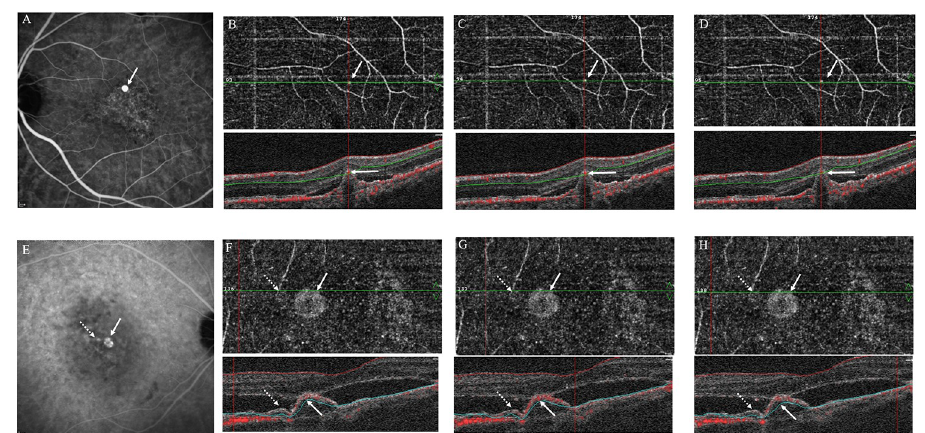
Fig 1. ICGA and OCTA of high-flow polyp and low-flow polyp. (A) ICGA revealed one polyp (arrow). (B~D) The polyp (arrow) was identified by en face flow OCTA, and flow signal (arrow) was identified by en face flow OCTA, and flow signal was detectable in all 3 consecutive horizontal scans at the center of the polyp. The polyp was then defined as “high flow.” (E) Two polyps identified on ICGA (arrow and dotted arrow). (F~H) En face OCTA and 3 consecutive horizontal scan of the 2 types of polyps. The flow signal of “high flow” polyp (arrow) was detectable in en face and all 3 consecutive horizontal scans, while the flow signal of the “low flow” polyp (dotted arrow) could not be detected in en face and all 3 horizontal